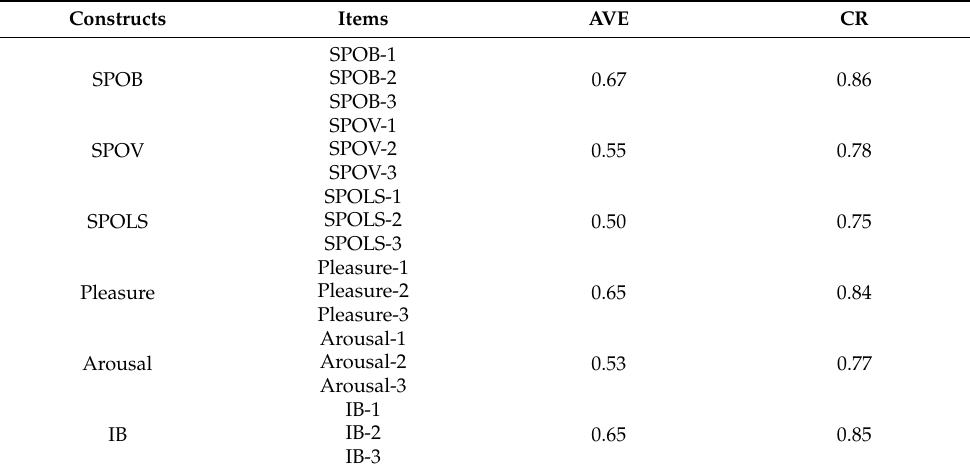
Table 3. The results of confirmatory factor analysis in the survey.